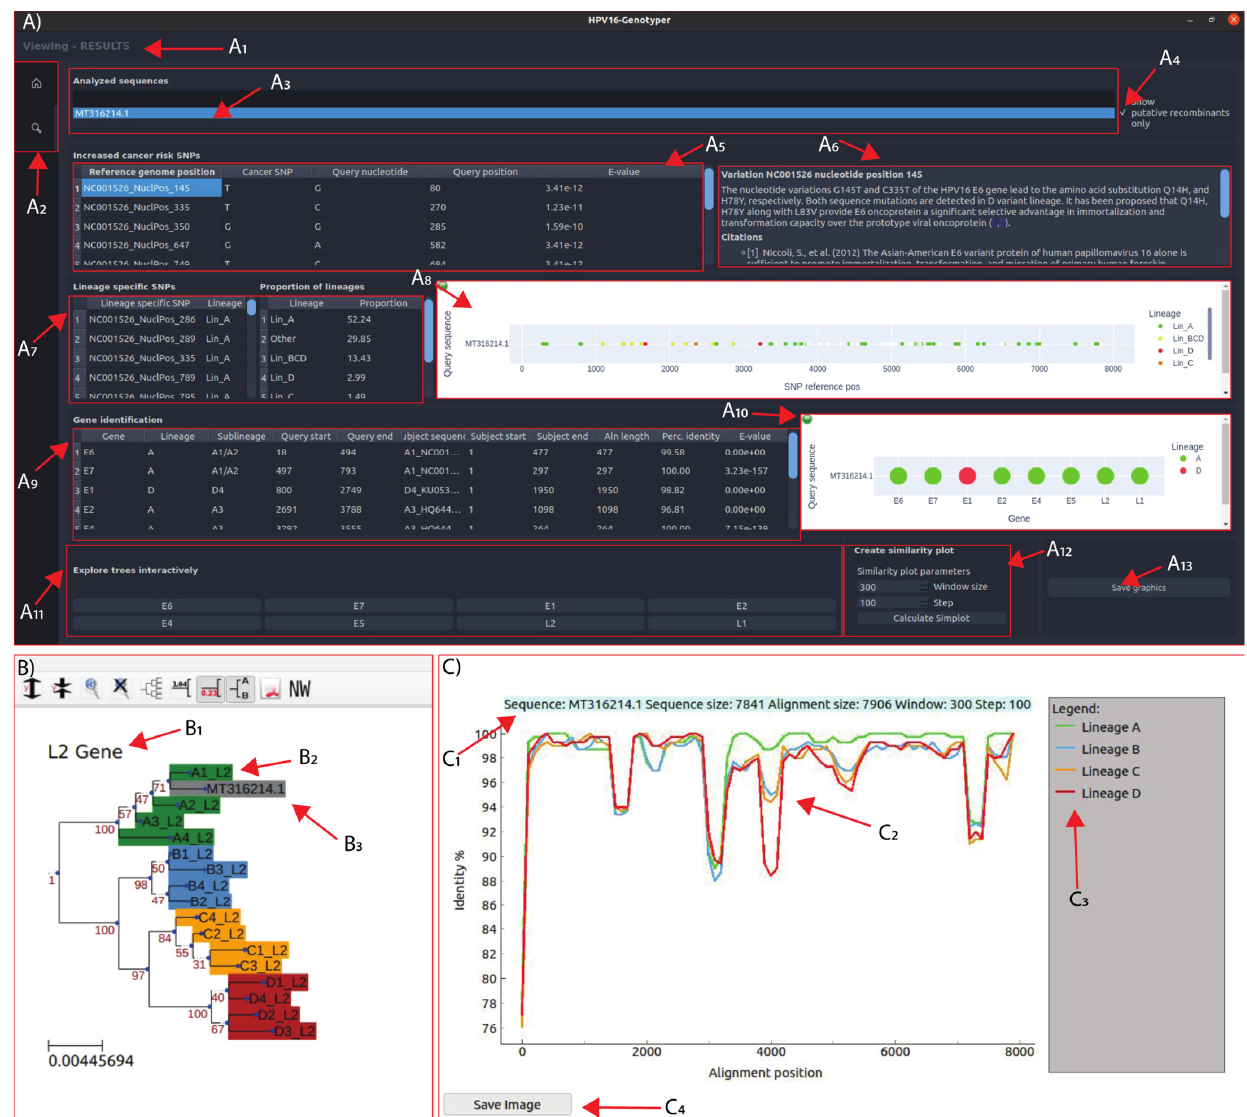
Figure 5. The HPV16 genotyper tool has three GUI components ( A – C ). The first component is the main results page. A1 is the status bar, where the user obtains information about the currently displayed page. A2 are the total pages available (Home and Results). The first frame of the results page contains A3, a list of all the analyzed sequences. By double clicking the name of a sequence, the page updates with the corresponding information. By checking the button A4, the list displays only the putative recombinants identified in the analysis. The next frame contains information about 9 SNPs associated with increased risk of cancer (A5) and clicking on any of the identified SNPs displays information (A6) about that specific SNP. A7 shows the lineage-specific SNPs identified in the selected sequence and this information is summarized in graph A8. BLAST results for each gene are shown in table A9 and summarized in graph A10. In the frame A11, the user has the option to view the phylogenetic tree for each gene. In case the selected sequence does not contain the selected gene, an error message will be displayed. The A12 frame gives the option to create the similarity plot of the selected sequence. A13 saves A8 and A10 on the output directory. Panel B shows an example interactive tree visualization, where B1 is the gene label, B2 shows the different reference sequences which are colored based on their lineage and B3 shows the selected sequence which will always be colored gray. Panel C shows an example similarity plot window. C1 is the plot description, C2 is the similarity plot, C3 is the plot legend and C4 is a button that can save the page in JPG format. More specifically, the software accepts sequences in FASTA format and first tries to determine which of them are HPV16 sequences or not (based on the 90% nucleotide iden- tity criterion). Next, the software scans each HPV16 sequence for the presence of any of